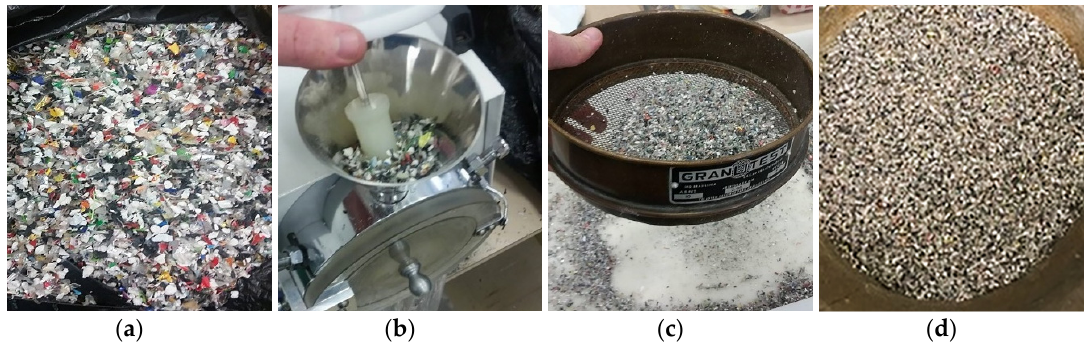
Figure 1. Plastic waste: ( a ) initial aspect; ( b ) milling; ( c ) sieving process; ( d ) final aspect.